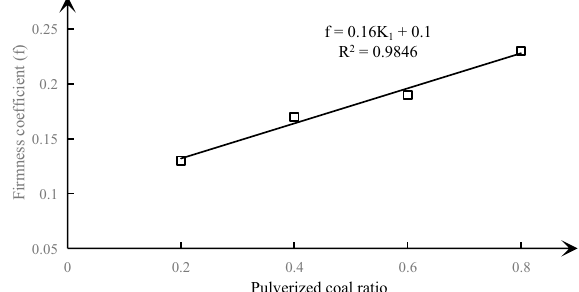
Figure 7. Curve of pulverized coal ratio and firmness coefficient under the condition of fixed sodium humate and river sand